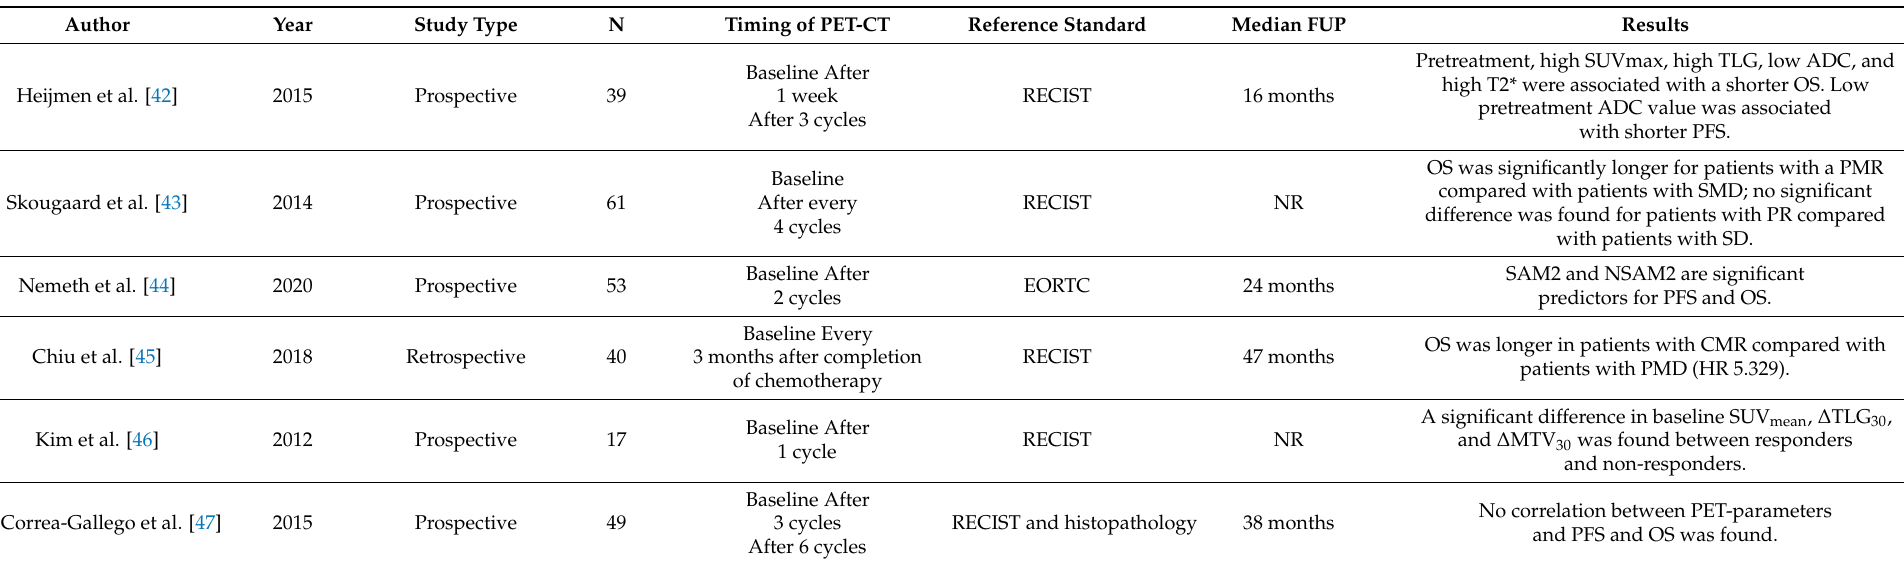
Table 4. Summary of literature studying PET-CT performance after palliative chemotherapy of colorectal liver